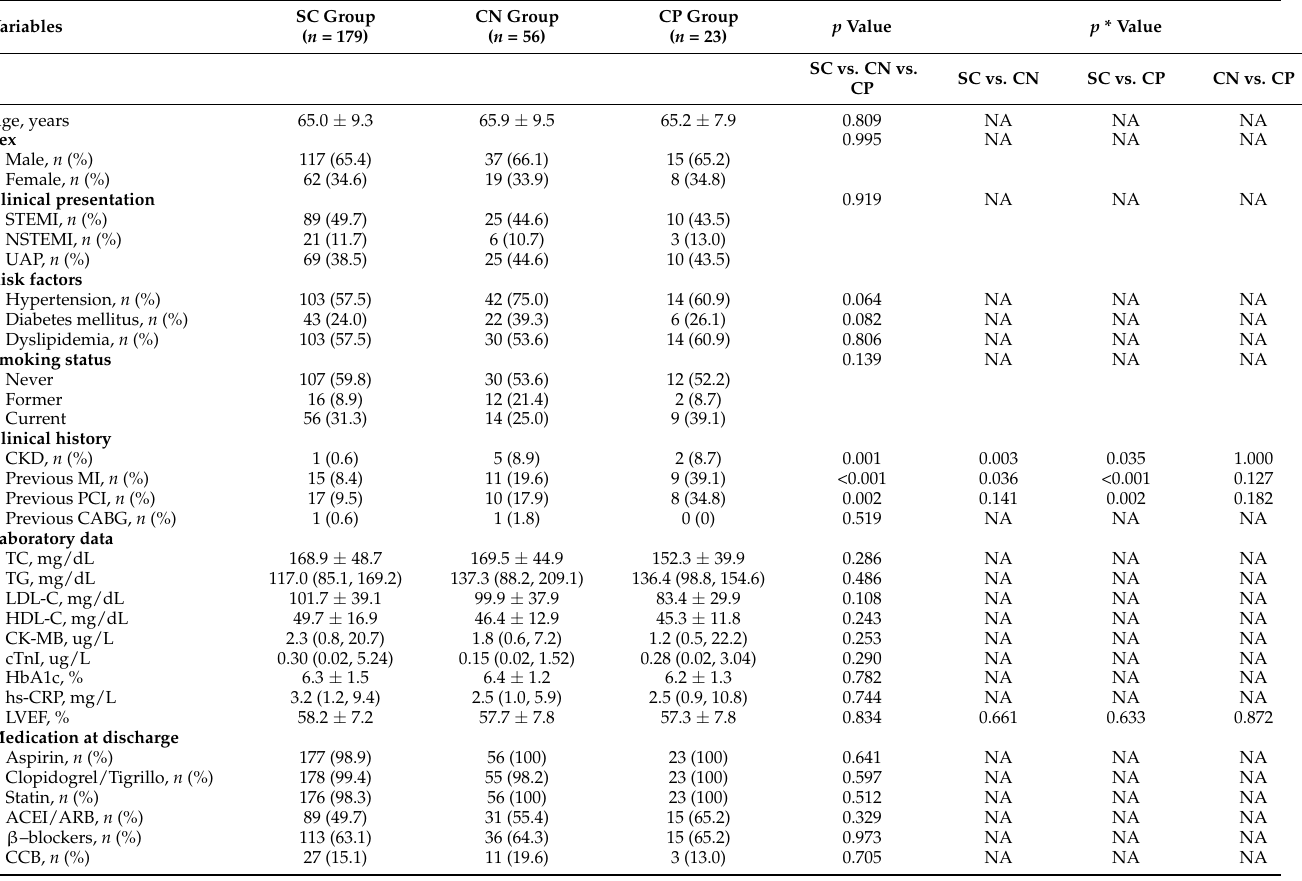
Table 1. Baseline clinical characteristics of different calcified culprit